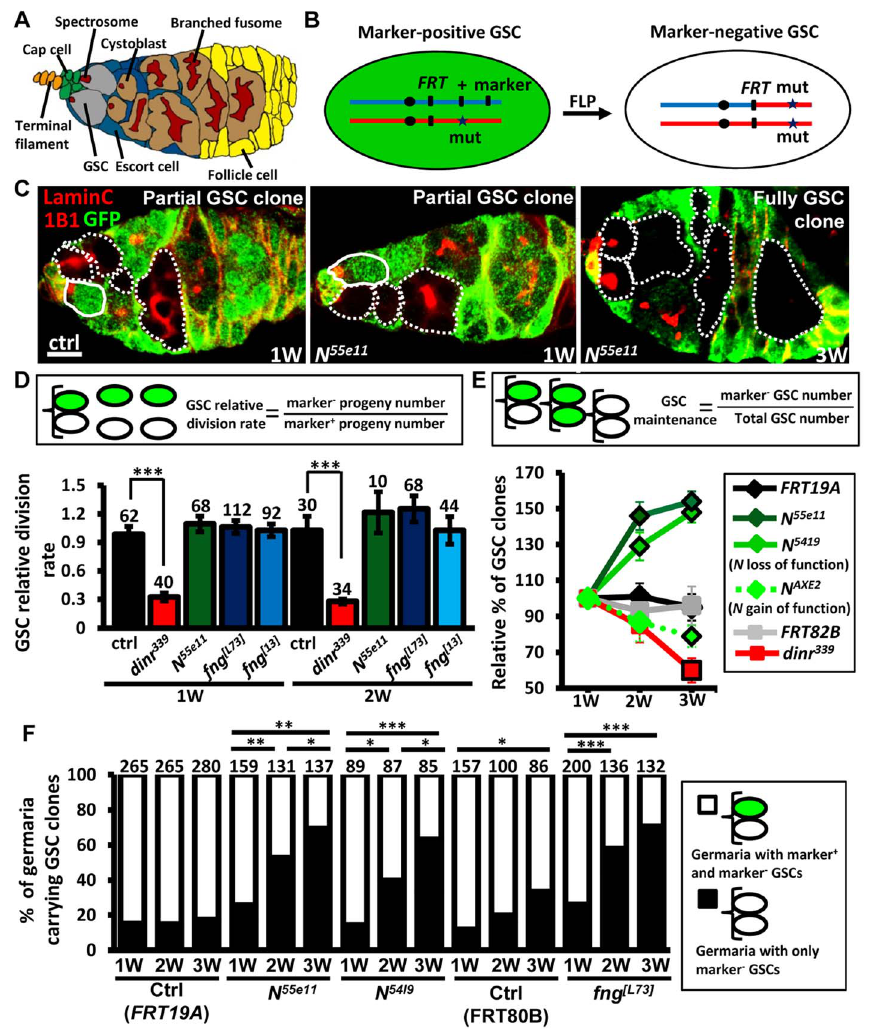
Fig. 1. Mutation of fng or N enhances GSC maintenance without affecting proliferation. (A) Drosophila germarium. The GSC niche, which consists of a terminal filament, cap cells, and anterior escort cells, houses two GSCs, which contain membranous organelles (spectrosomes or fusomes). One GSC division gives rise to a cystoblast, which then develops into cyst cells that are interconnected with a branched fusome. The cyst is then surrounded by somatic follicle cells. (B) Mitotic recombination was used to generate GSCs mutant for N or fng . Females carrying a wild-type (wt) allele linked to a marker gene ( GFP or ß-gal ) in trans with a mutant (mut) allele were generated. FLP-mediated recombination between FRT sites during mitotic division generates a homozygous mutant cell, identifiable by the absence of marker expression. (C) Mosaic germaria with GFP (green, wt cells), 1B1 (red, GSC fusomes) and LamC (red, cap cell nuclear envelopes) labels. Wt GSCs are outlined by solid lines. GFP-negative GSCs and their daughter cells are outlined by dashed lines. One-week (w)-old control (ctrl) and N 55e11 mutant germaria contain one wt and one GFP-negative GSC (partial GSC clone) and their progeny. Three-w-old N 55e11 mutant germaria contain two GFP-negative GSCs (full GSC clone) and their progeny. Scale bar, 5 m m. (D) GSC relative division rate (ratio of marker-negative to marker-positive GSC progeny) in mosaic germaria. The number of GSCs analyzed is shown above each bar. (E) Relative percentage of GSC clones (as a proportion of total GSCs) at 1, 2, and 3w after clone induction. (F) Relative percentage of germaria carrying partial GSC clones vs. germaria carrying full GSC clones at 1, 2, and 3w after clone induction. The number of germaria analyzed is shown above each bar. *, P , 0.05; **, P , 0.01; ***, P , 0.001. Error bars, mean 6 SEM. The genotype of the control germaria in E and F is hs- flpneoFRT19A/ubiGFPFRT19A ( FRT19A ). FRT80B and FRT82B refer to hs-flp/ + ; neoFRT80B/armlacZFRT80B and hs-flp/ + ; FRT82Bneo/FRT82BarmlacZ , respectively.